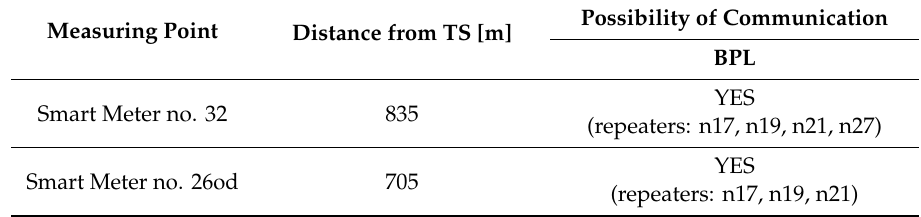
Table 4. Possibility of BPL communication with repeaters.